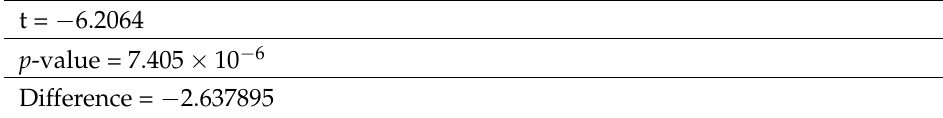
Table 2. Results of paired t -test applied to data of Experiment 1. t = −